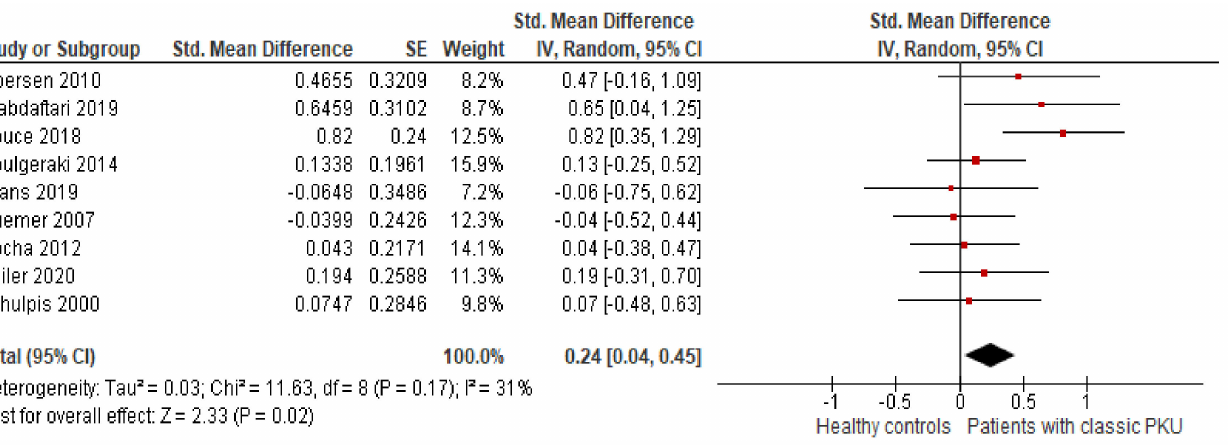
Figure 4. Forest plot comparing the BMI between patients with classical PKU and healthy controls. Abbreviations: BMI: body mass index; CI: confidence interval; df: degrees of freedom; IV: inverse variance; PKU: phenylketonuria; SE: standard error; Std: standardised. Moderate risk of bias: Couce 2018, Evans 2019, Huemer 2007, and Rocha 2012. High risk of bias: Albersen 2010, Azabdaftari 2019, Doulgeraki 2014, Sailer 2020, and Schulpis 2000. Time of diagnosis: Couce 2018 included 70 early- and 13 late-diagnosed patients, and Schulpis 2000 did not provide information on the time of diagnosis. Metabolic control: Azabdaftari 2019 included only one patient with good metabolic control (Phe blood levels < 600 µ mol/L). BH4 treatment: Couce 2018 included 1 (3%) patient taking BH4, and Sailer 2020 included 4 (13%)